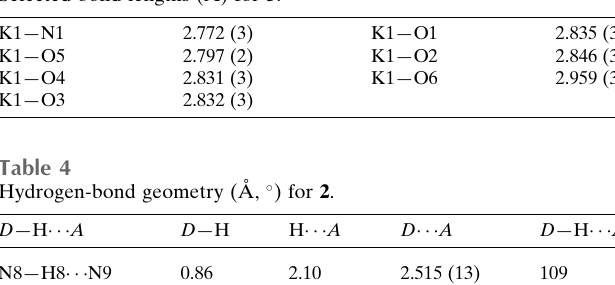
Table 3 Selected bond lengths (A˚ ) for 3 .